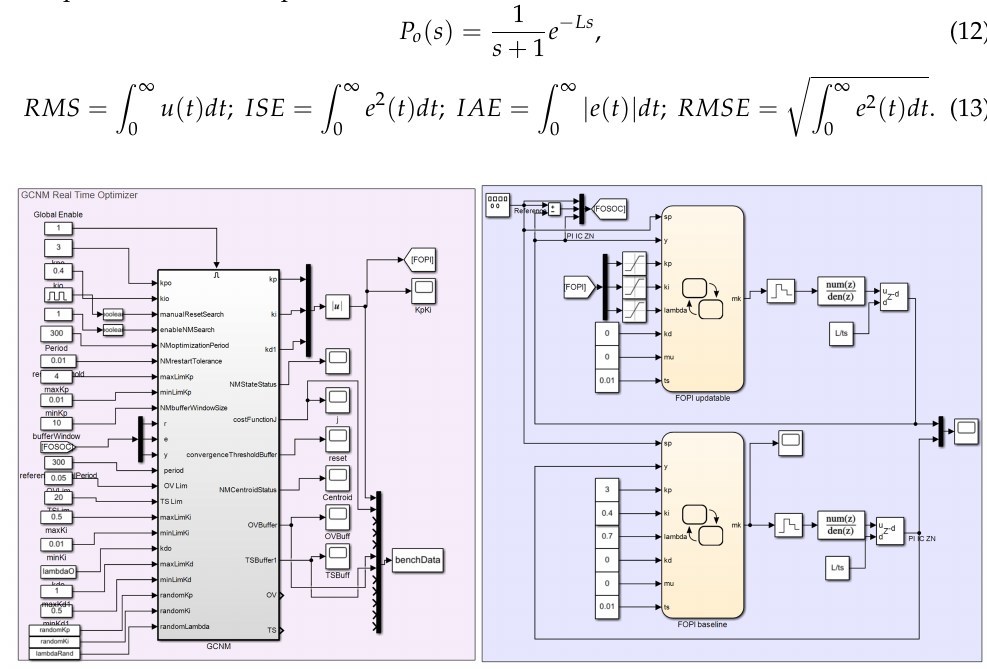
Figure 3. FOSOC benchmark in Matlab/Simulink and fractional-order PI controller implementation using